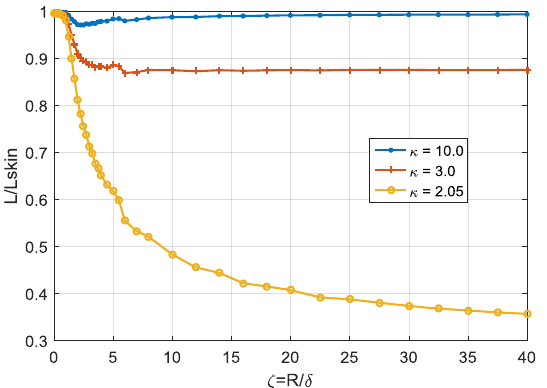
Figure 1: The ratio 𝐿/𝐿 𝑠𝑘𝑖𝑛 computed with the parameter set (𝑚, 𝑛, 𝑁 ) = (1,2,20) in function of 𝜁 for 𝜅 = 𝑚𝑖𝑛 10.0, 3.0, and 2.05 , in this order from top to bot- tom.